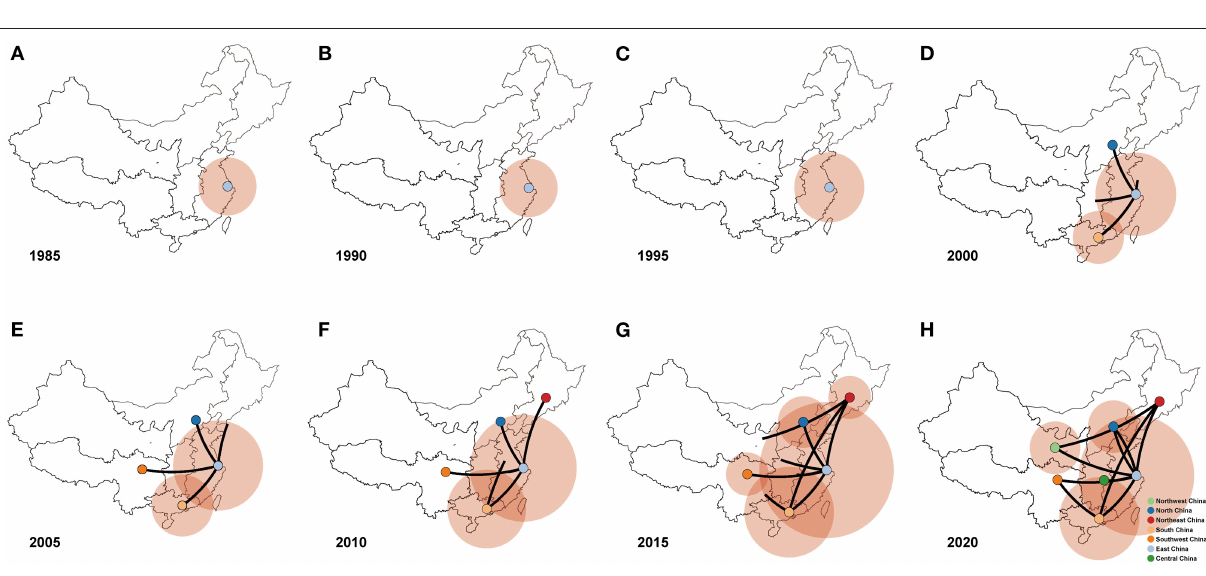
that PPMV-1 has a high host preference for pigeons ( Figure 4A